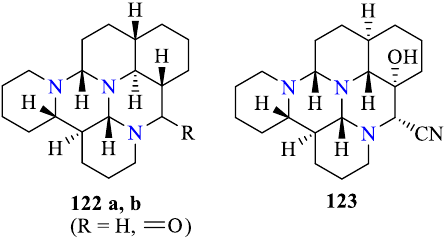
Figure 6. Myrioneuron types alkaloids.